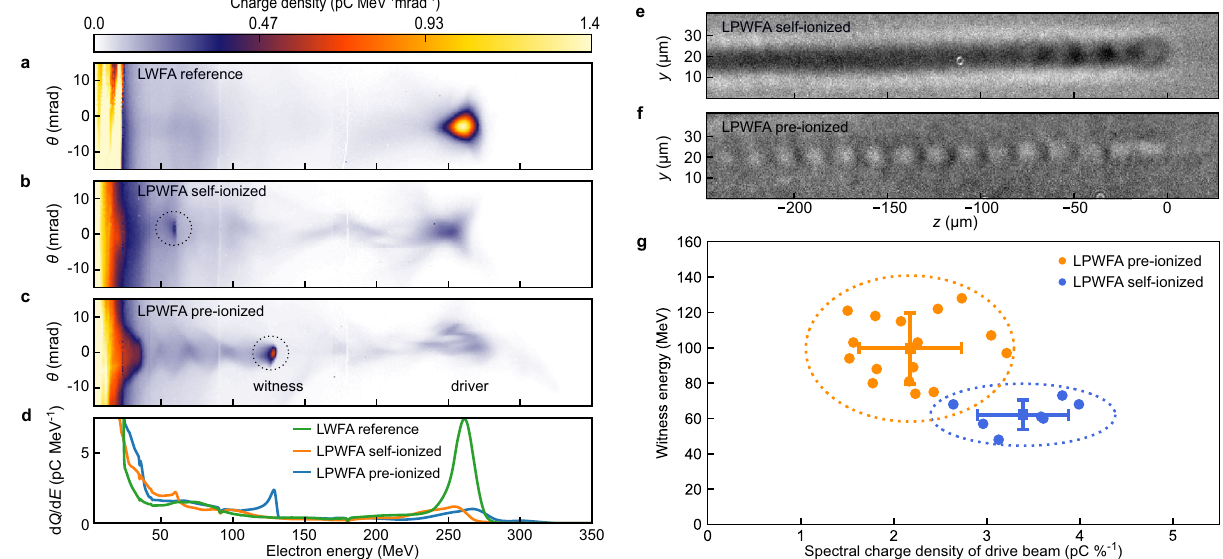
Fig. 2 Representative electron spectra, plasma wave shadowgrams, and statistical analysis of witness beam energy. a Energy spectrum of LWFA electrons transmitted through the steel foil without operating the PWFA stage, with θ representing the divergence. b LPWFA spectrum without pre-ionizing laser. c LPWFA spectrum with the PWFA stage ionized prior to the drive beam arrival. d Charge distribution integrated over ±6 mrad divergence: green line corresponds to a , orange to b , and blue to c . Additional spectra used for determining the statistical parameters can be found in Supplementary Fig. 3, with the measured drive beam parameters from all shots summarized in Supplementary Table 1. e Plasma wake fi eld shadowgram at the center of the PWFA stage, with the drive beam propagating to the right and ionizing the gas by means of its electric fi eld (self-ionized case). The ionized channel (dark region) and several plasma wake fi eld oscillations directly behind the driver are visible. f Corresponding shadowgram of a plasma wake fi eld in the pre-ionized case. The plasma wave structure is more pronounced and shows more subsequent cavities than in the self-ionized case, indicating a stronger wake fi eld excitation. g Measured witness energy correlated with the remaining spectral charge density of the drive beam. The data points represent spectra exhibiting clear witness beams in the pre-ionized (orange, 37% of shots) and self-ionized case (blue, 28% of shots). The squares denote the mean value of each set with error bars visualizing the root mean square shot-to-shot fl uctuations and ellipses encircling the area of 2 SDs. Operating the LPWFA with pre- ionization results in consistently higher witness beam energy gain together with stronger driver